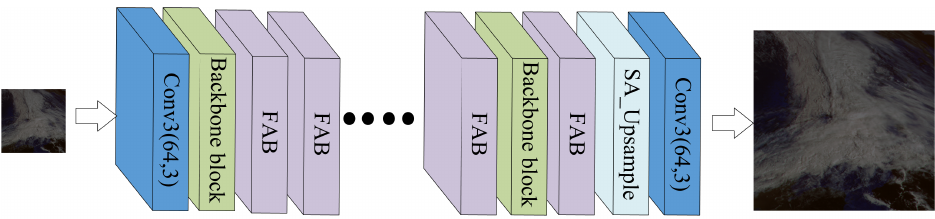
Figure 10. Structure of scale-arbitrary super-resolution